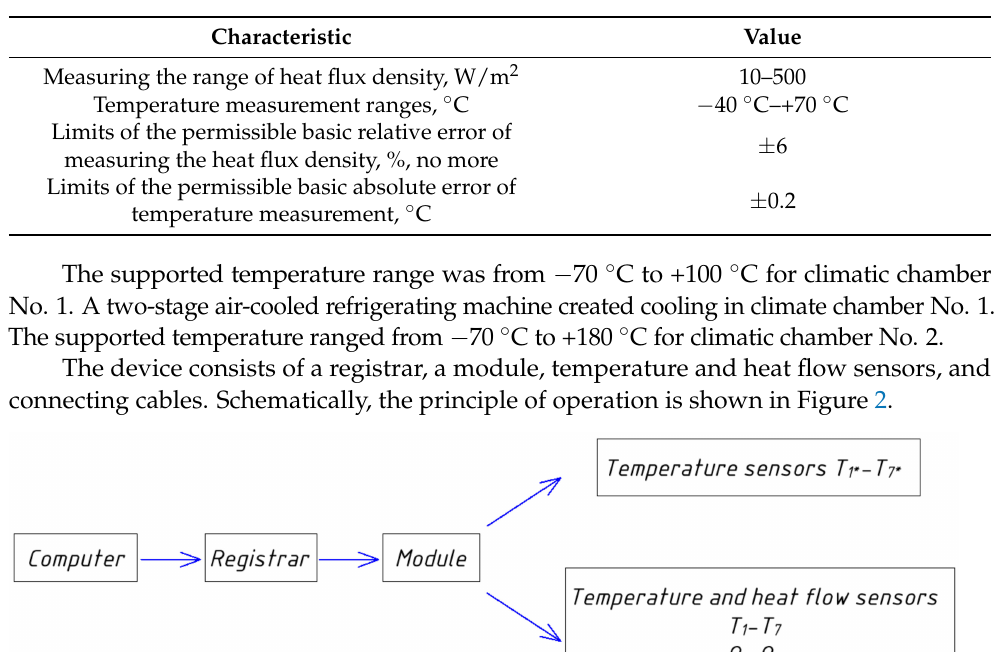
Table 1. The technical characteristics of the heat flux density and temperature meter.